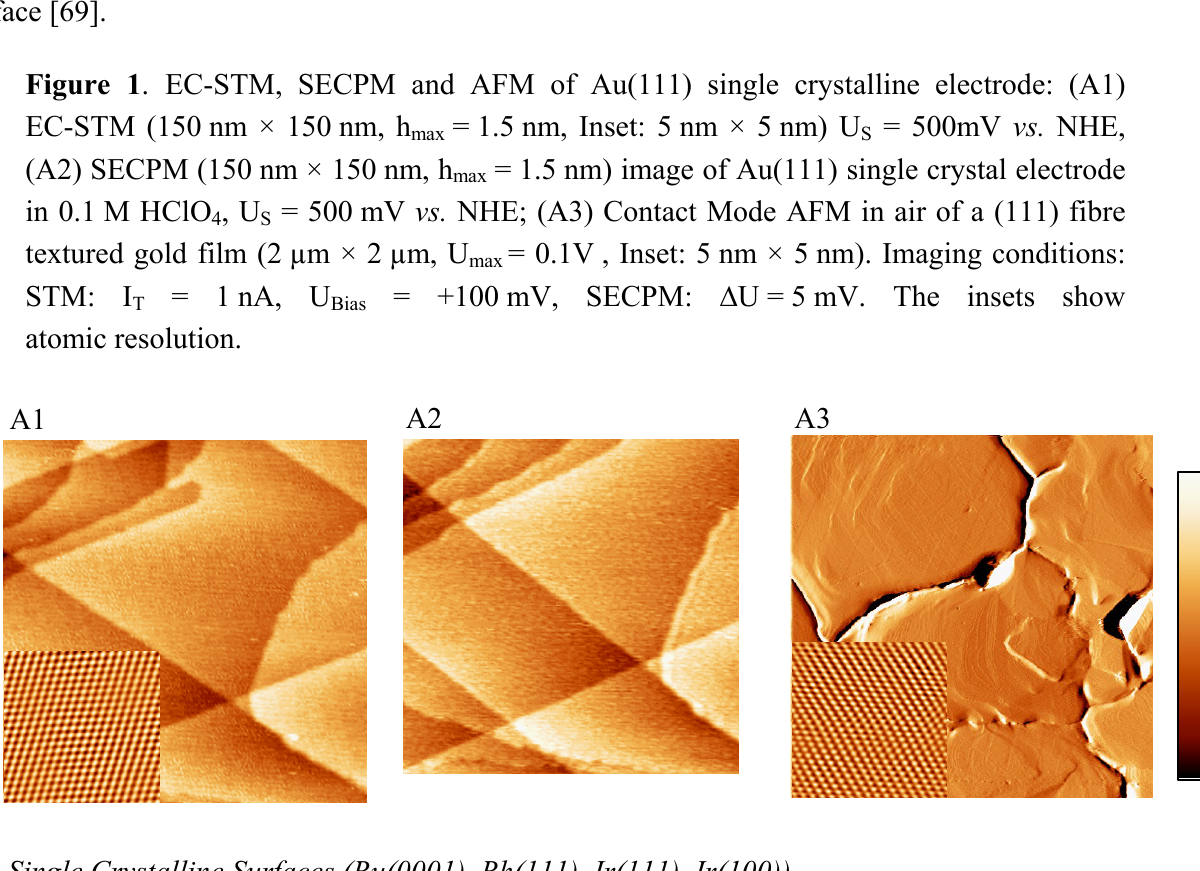
Figure 1 . EC-STM, SECPM and AFM of Au(111) single crystalline electrode: (A1) = 1.5 nm, Inset: 5 nm × 5 nm) U EC-STM (150 nm × 150 nm, h max = 1.5 nm) image of Au(111) single crystal electrode (A2) SECPM (150 nm × 150 nm, h max in 0.1 M HClO , U = 500 mV vs. NHE; (A3) Contact Mode AFM in air of a (111) fibre 4 S